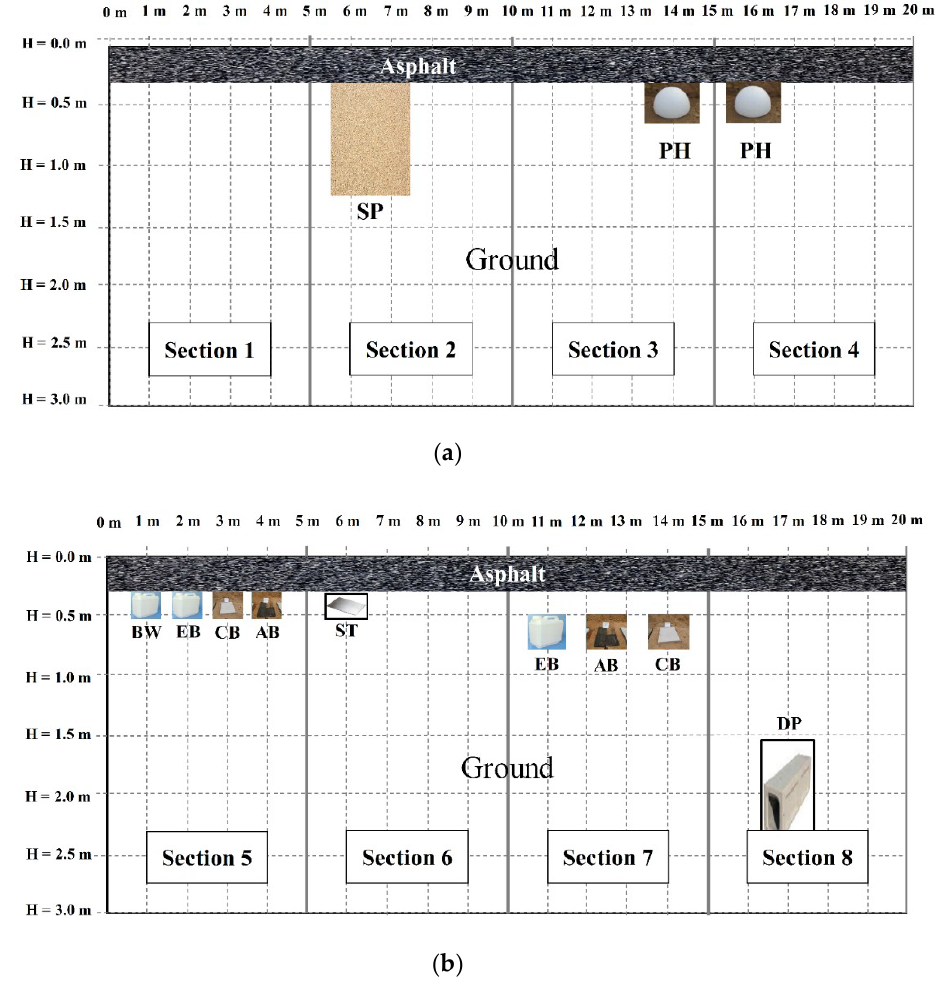
Figure 2. Side views of the testbed sections. ( a ) Sections 1–4. ( b ) Sections 5–8.